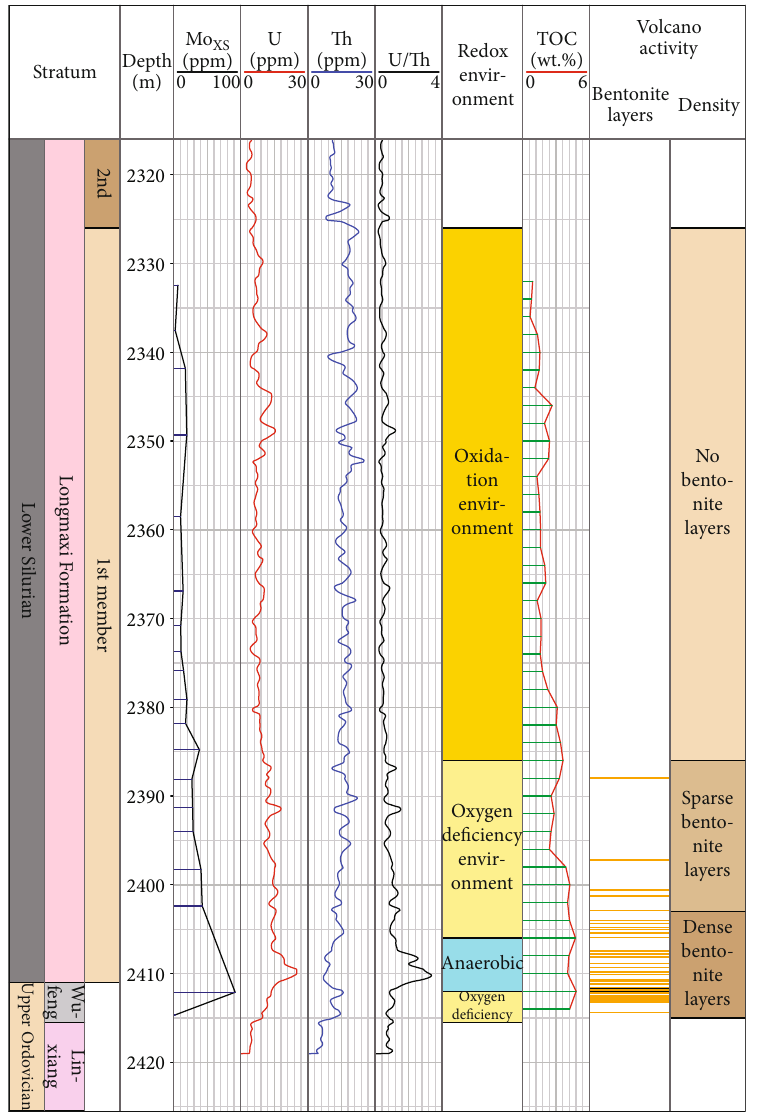
Figure 5: Column of Mo , redox environment, TOC content, and growth layer of bentonite in the lower upper Ordovician Wufeng XS Formation and lower Silurian Longmaxi Formation in the well JSBY1 of the upper Yangtze region (see Figure 1 for the well